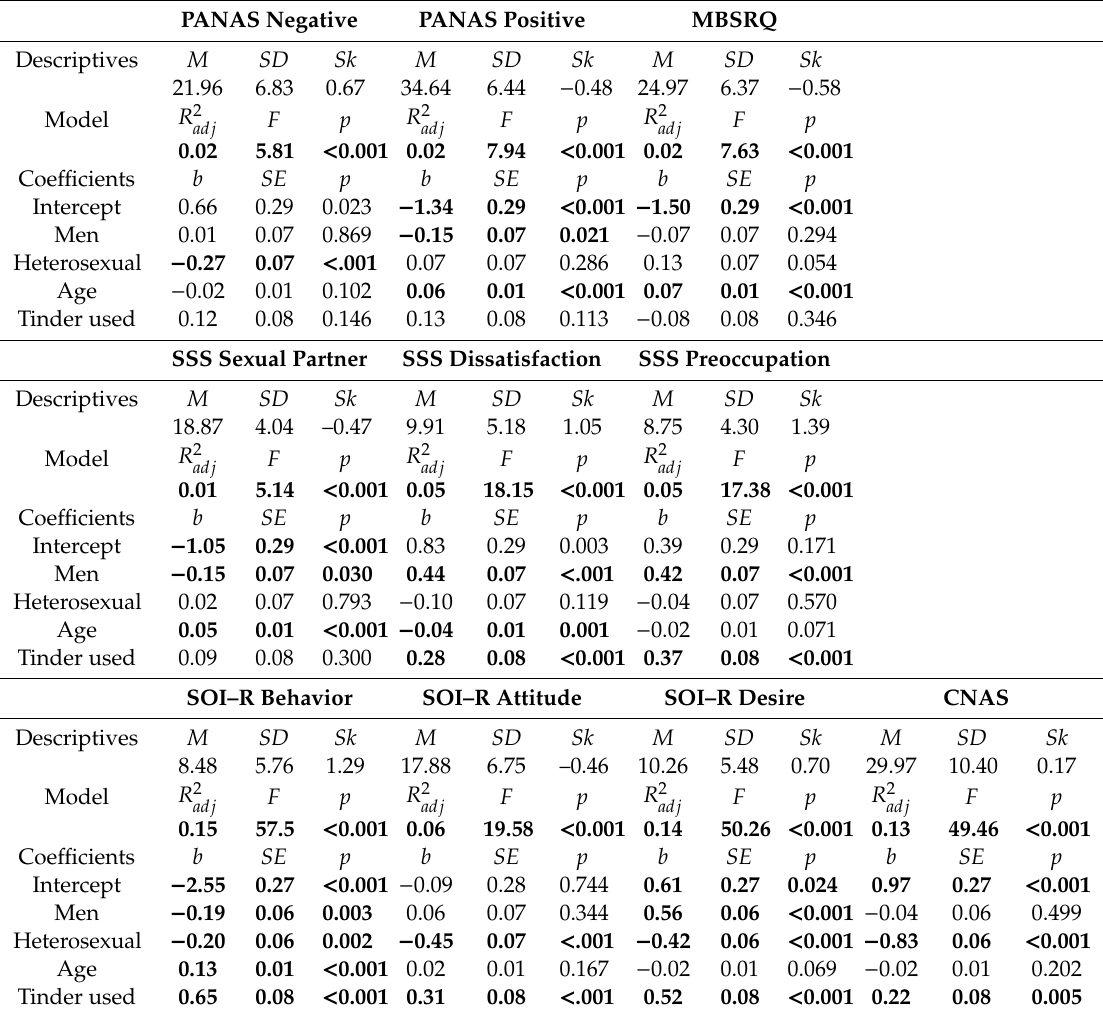
Table 5. Multiple regression analysis of the di ff erent psychosexual variables. PANAS Negative PANAS